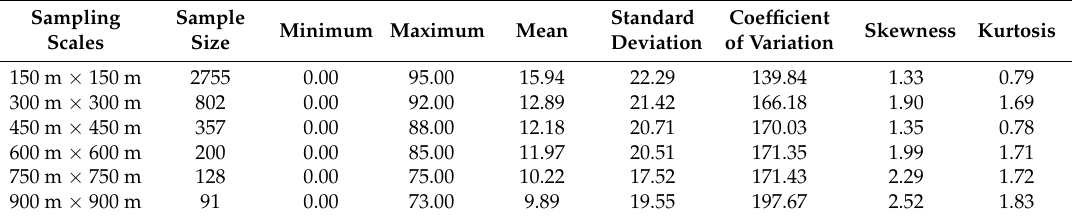
Table 1. Description and statistics of rock exposures under different sampling